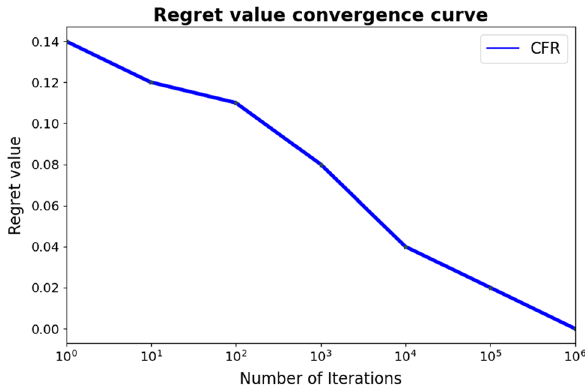
Figure 9. Algorithm performance analysis.